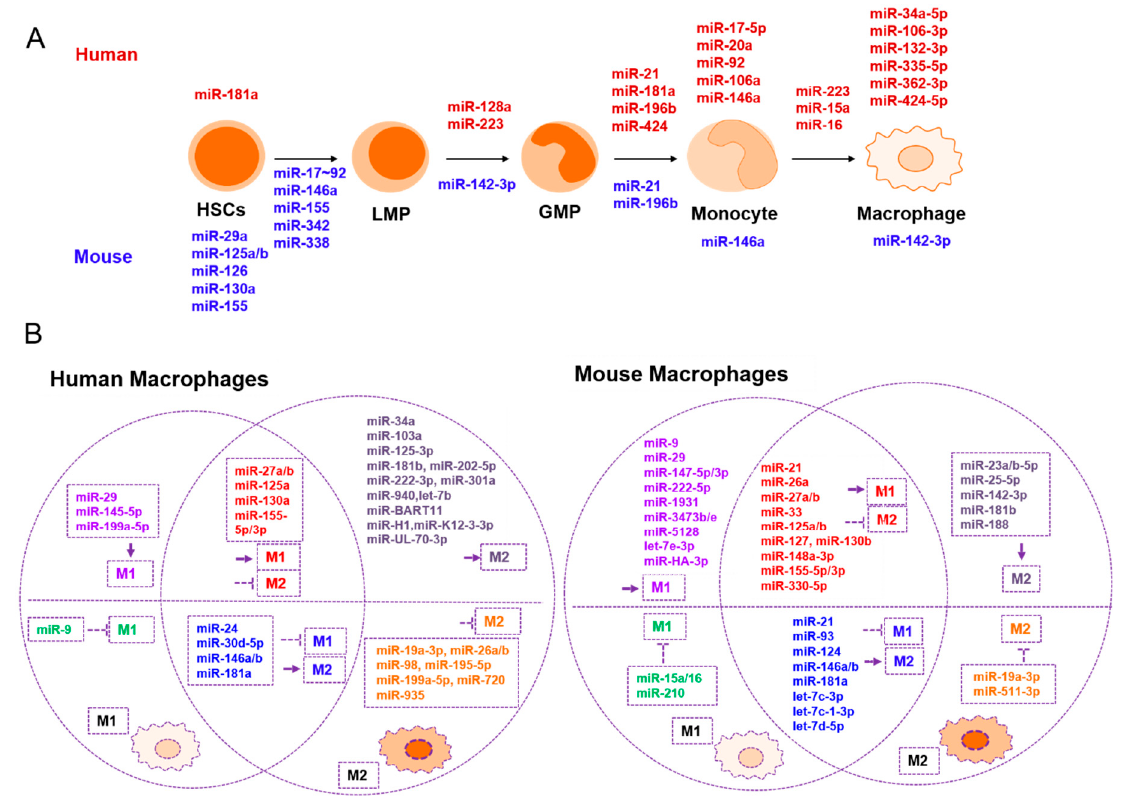
Figure 1. miRNAs are involved in macrophage development, polarization, and tumor immunity. ( A ) miRNAs involved in mouse and human macrophage development and maturation. miRNAs listed without arrows participate in each step of cell di ff erentiation or maturation, while miRNAs listed with arrows function in the developmental transition. ( B ) The role of miRNAs in classical M1 macrophage activation or M2 macrophage alternative activation in humans and mice. Di ff erent colors indicate the di ff erent roles that miRNAs play in macrophage polarization. HSCs, hematopoietic stem cells; LMP, common lymphoid progenitor; GMP, granulocyte-macrophage progenitor; M1, classically activated macrophages; M2, alternatively activated